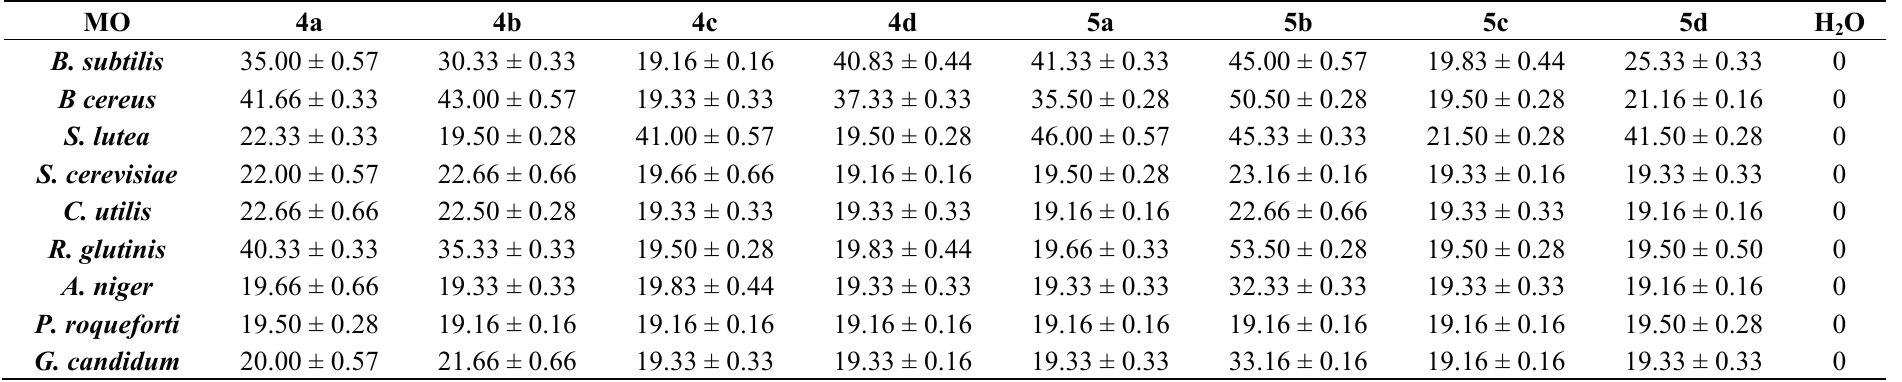
Table 1. Diameters expressed in mm of growth inhibition zone of the bis-pyridinium quaternary ammonium salts (bis-PyQAs) 4a – d and 5a – d . Values are presented as the mean ± SEM. The diameter of the test paper discs is 19